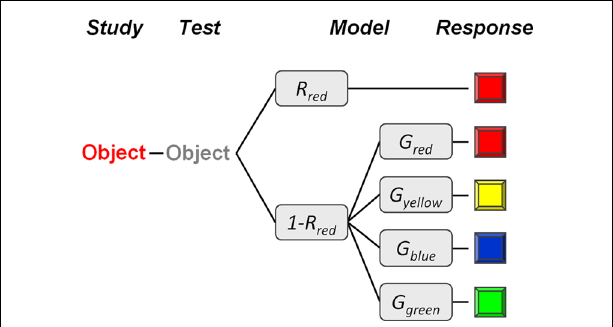
FIGURE 2 | Illustration of the multinomial model. Subjects are assumed to have a veridical memory of an object’s original color (e.g., red) with probability R (e.g., R red ), and to guess one of the four colors with the probability G (e.g., G red ) in the absence of memory for the object’s original